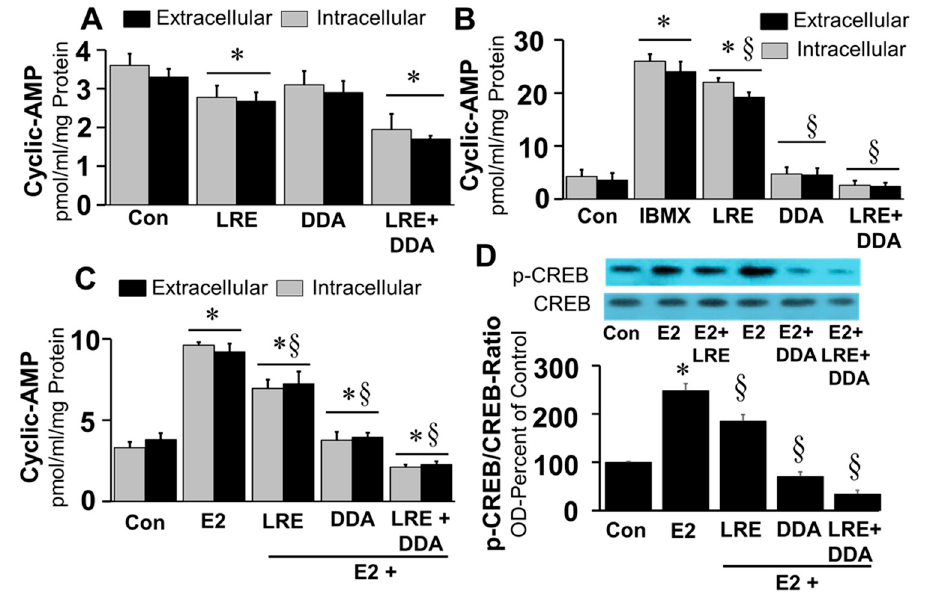
Figure 9. Figure depicting the inhibitory effects of sAC inhibitor, LRE1 (50 µ M), tmAC inhibitor DDA (10 µ M) and LRE1 (50 µ M) plus DDA (10 µ M) on basal (Panel ( A )), IBMX (1 µ M, Panel ( B )); and E2 (20 ng/mL, Panel ( C )), stimulated changes in intracellular and extracellular cyclic AMP levels in FT cells after treatment for 15 min. Panel ( D ) shows the effects of LRE1 (50 µ M), DDA (10 µ M) and LRE1 (50 µ M) plus DDA (10 µ M) on E2 (20 ng/mL) induced phosphorylation of CREB in FT cells treated for 30 min. Data for cAMP (mean ± SEM) represent the mean of three different experiments in triplicate ( n = 3). Results for phosphorylated CREB were normalized with non-phosphorylated CREB and expressed as percent of control. * p < 0.05 vs. untreated control, Con; § p < 0.05 vs. treatment with E2, IBMX, LRE or DDA alone.